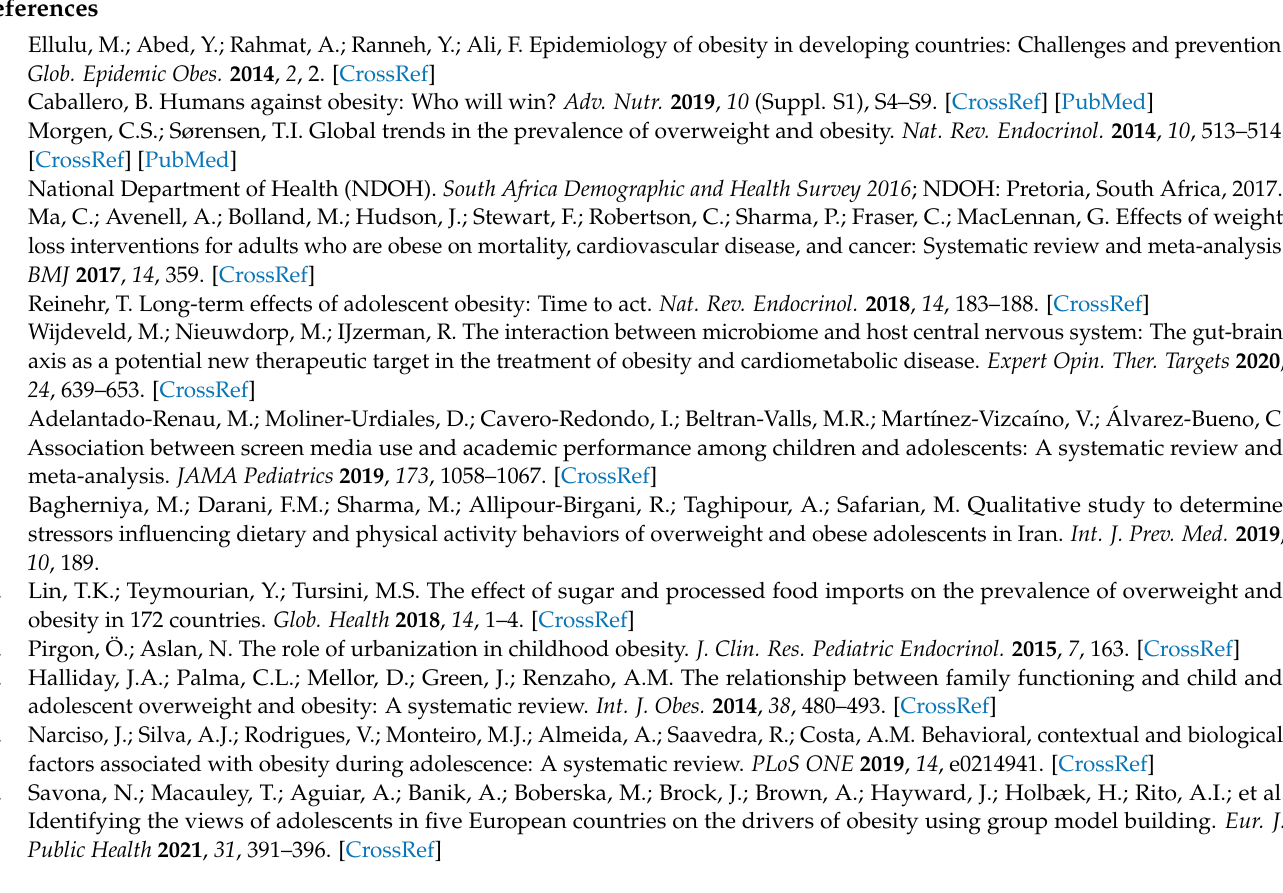
Figure A4. School map